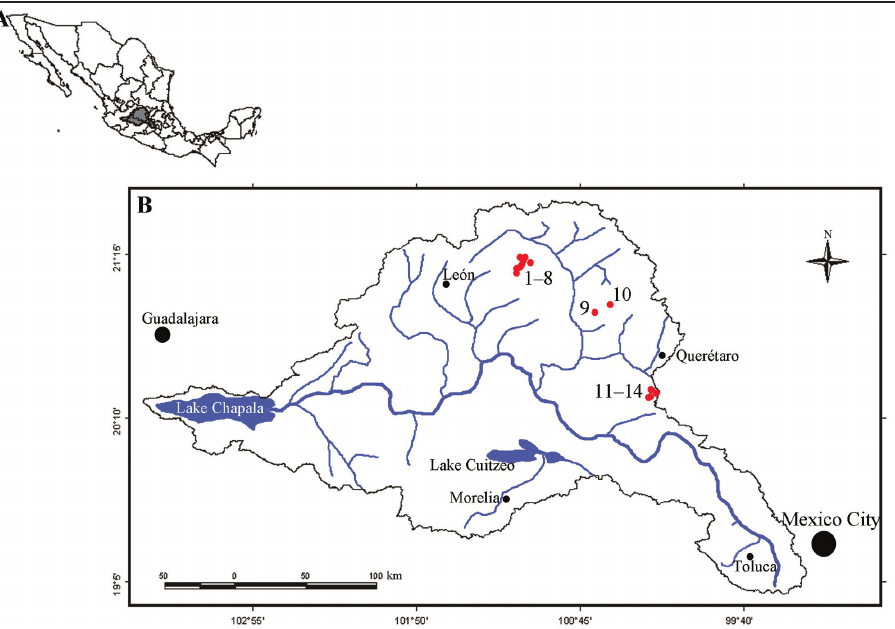
Figure 1. Location of the area of study. A Map of Mexico, showing the location of the Lerma-Chapala Basin in the center of the country. B Location of the 14 sampling sites in the Lerma-Chapala Basin, in- dicated by red dots. The numbers next to the red dots refer to the name of the sampling site in Table